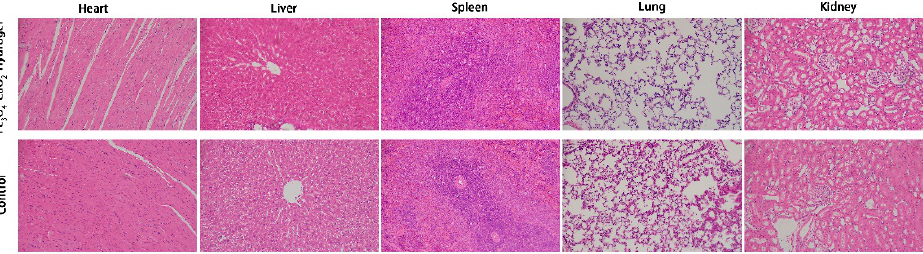
Figure 6. H&E stained images of major organs (heart, liver, spleen, lung, and kidney) collected from the Fe 3 O 4 -CaO 2 -Hydrogel group and the Control group.